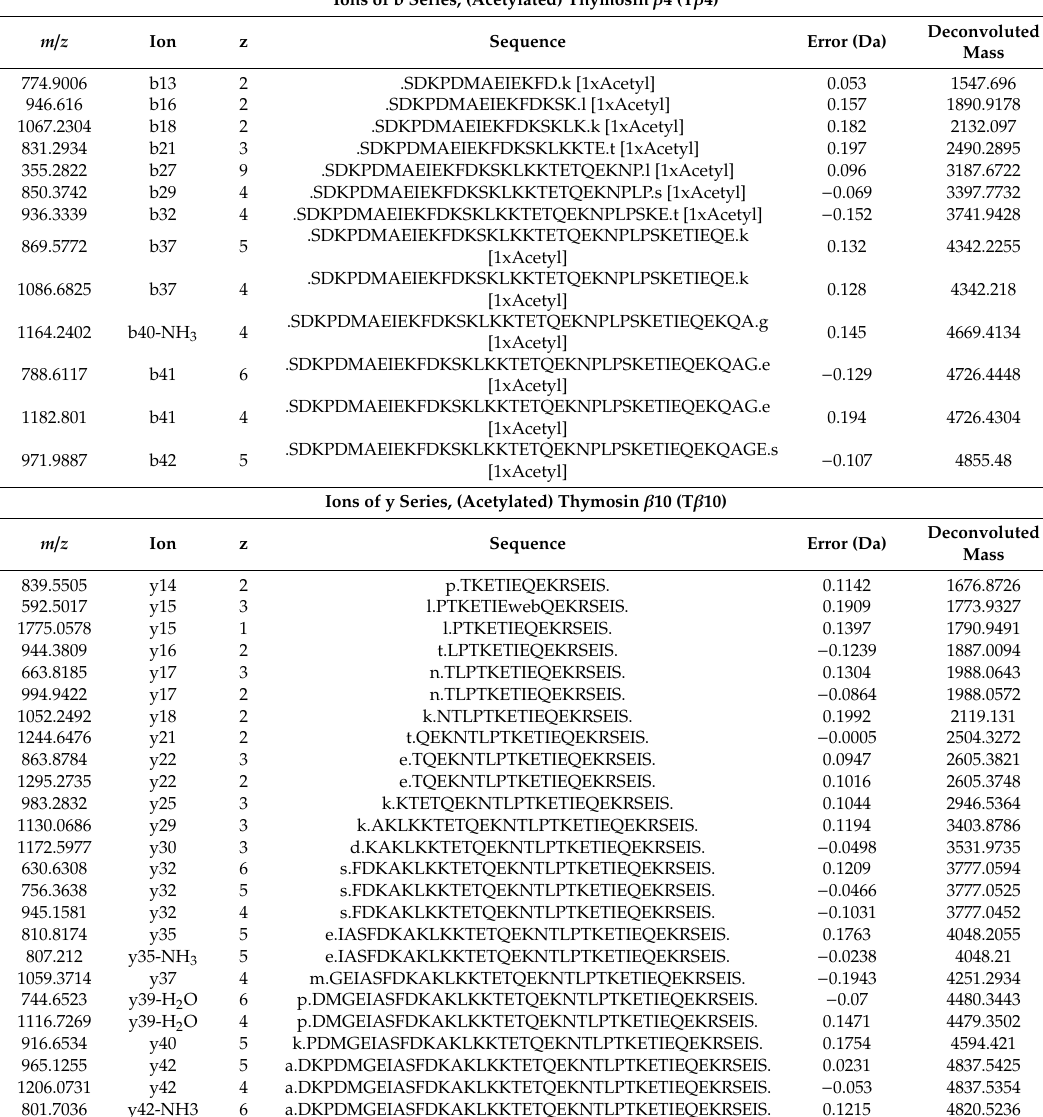
Table 3. Matched ions of b series, with the MS / MS fragmentation profile of the penta- ( m / z 993.5027) and exa- ( m / z 828.0855) charged (acetylated) thymosin β 4 (T β 4), and matched ions of the y series, with the MS / MS fragmentation profile of the penta- ( m / z 988.2166) and exa- ( m / z 823.5936) charged (acetylated) thymosin β 10 (T β